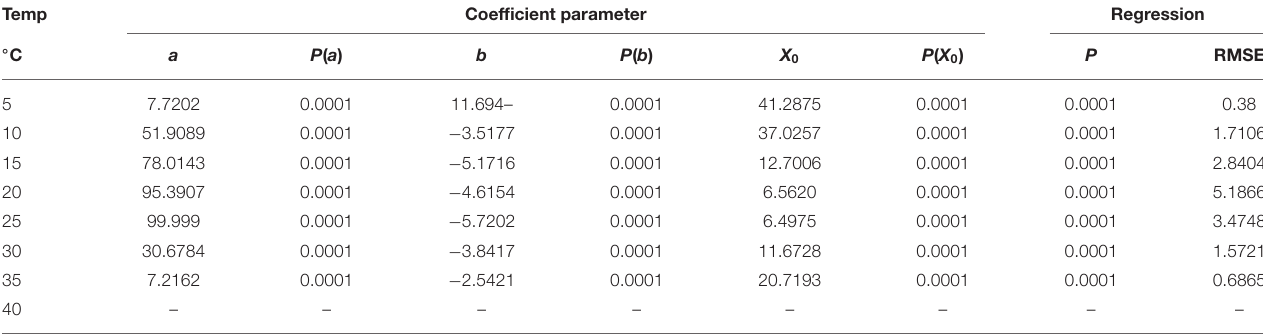
TABLE 1 | The coefficient of three parameters log-logistic equation fitted to describe the germination of Parthenium hysterophorus seeds under constant temperatures. Temp Coefficient parameter Regression